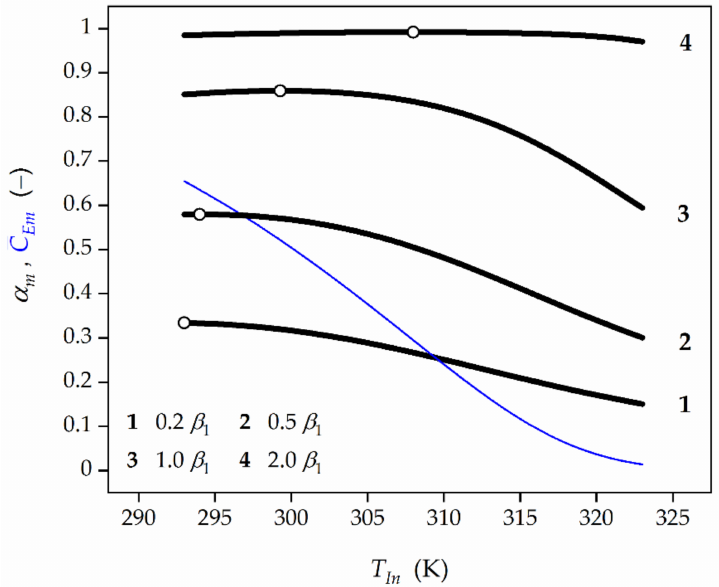
Figure 6. Effect of feed temperature ( T In ) and initial TUC activity ( β 1 ) on the average HP conversion (black lines) at the reactor outlet as well as TUC activity (blue line). Open symbols represent the maximum HP